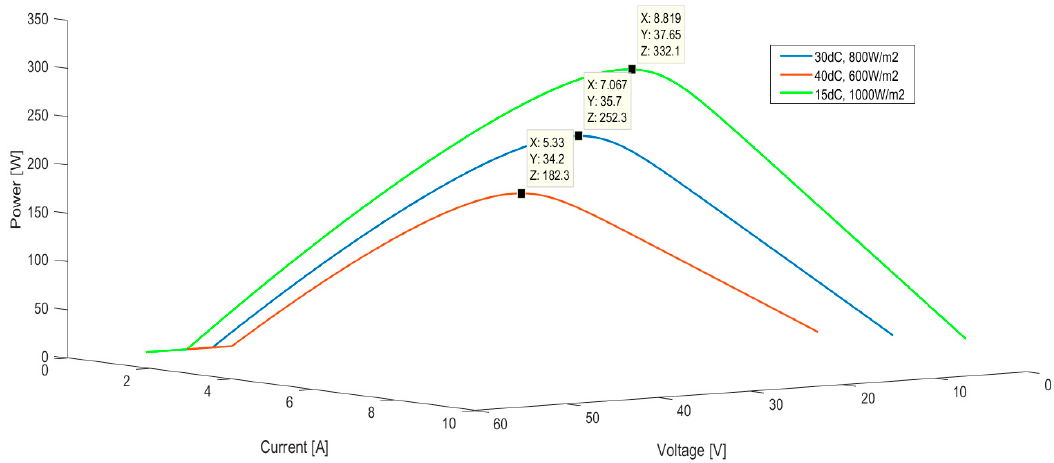
ff erent temperature and